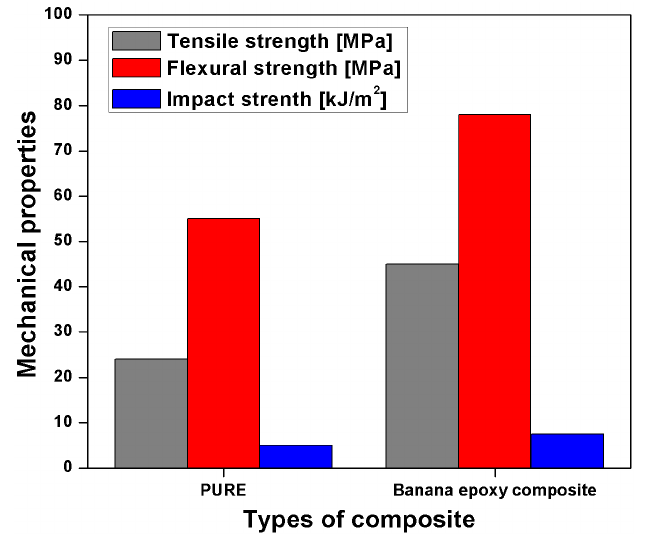
Figure 21. Mechanical properties of pure epoxy and pseudo-stem woven fabric banana-reinforced epoxy (BRE) composite.